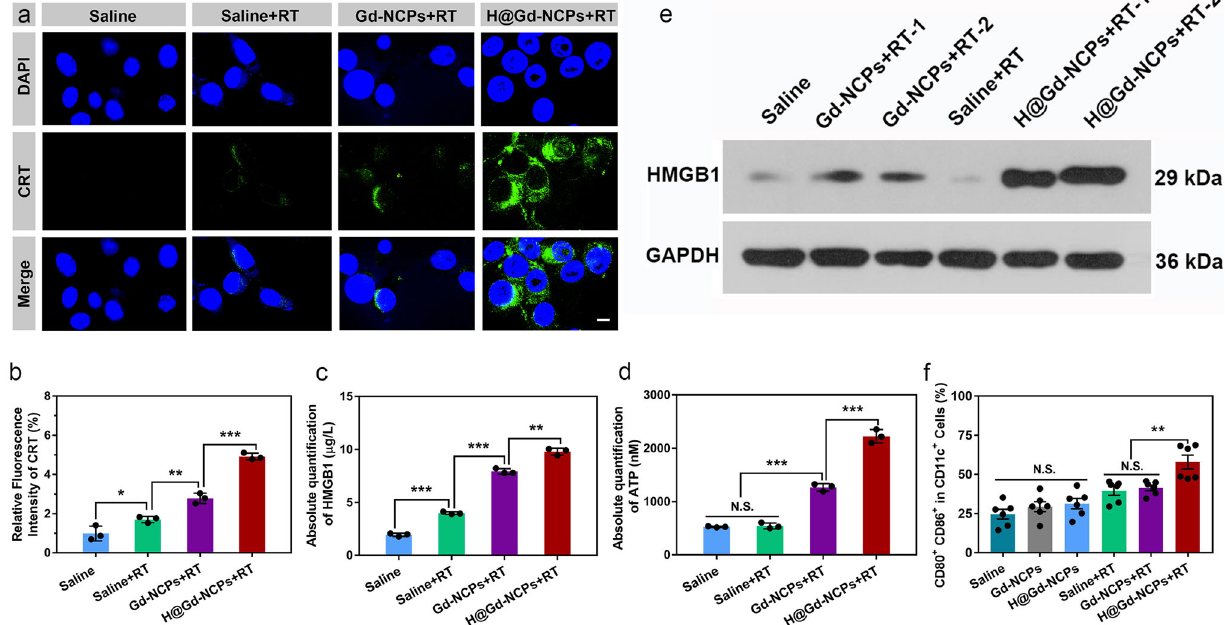
Fig. 6 Immunogenic cell death induction in vitro and in vivo. a Immuno fl uorescence of CT26 colorectal tumor cells stained with calreticulin (CRT) antibody ( n = 3 biologically independent cells), RT 0 or 8 Gy × 1, scale bar = 5 μ m. This experiment was repeated twice independently with similar results. b Quanti fi cation of relative CRT means fl uorescence intensity after different treatments ( n = 3 biologically independent cells, * p = 0.0389, ** p = 0.0037, *** p = 0.0003). c Detection of high mobility group protein B1 (HMGB1) release by ELISA kit ( n = 3 biologically independent cells, *** p = 0.0001, *** p = 0.0001, ** p = 0.0014), RT 0 or 8 Gy × 1. This experiment was repeated twice independently with similar results. d Detection of adenosine triphosphate (ATP) secretion by luciferin-based ATP assay kit ( n = 3 biologically independent cells, *** p = 0.0001, *** p = 0.0003), RT 0 or 8 Gy × 1. This experiment was repeated twice independently with similar results. e Western blot of HMGB1 in CT26-bearing mice tumor tissues after various treatments, the tumor tissues were harvested 48 h after radiotherapy (0 or 6 Gy × 1, n = 3 biologically independent animals). This experiment was repeated once independently with similar results. f Flow cytometry analysis of dendritic cells (DCs) maturation in tumor-draining lymph nodes (TDLNs), the TDLNs were harvested 5 days after radiotherapy (0 or 6 Gy × 1, n = 6 biologically independent animals, ** p = 0.0063). All data were presented as mean ± SD. Two-sided Student ’ s t -test was used to calculate the statistical difference between two groups. N.S. represented non-signi fi cance, and * p < 0.05, ** p < 0.01, *** p < 0.001. Source data are provided as a Source data fi